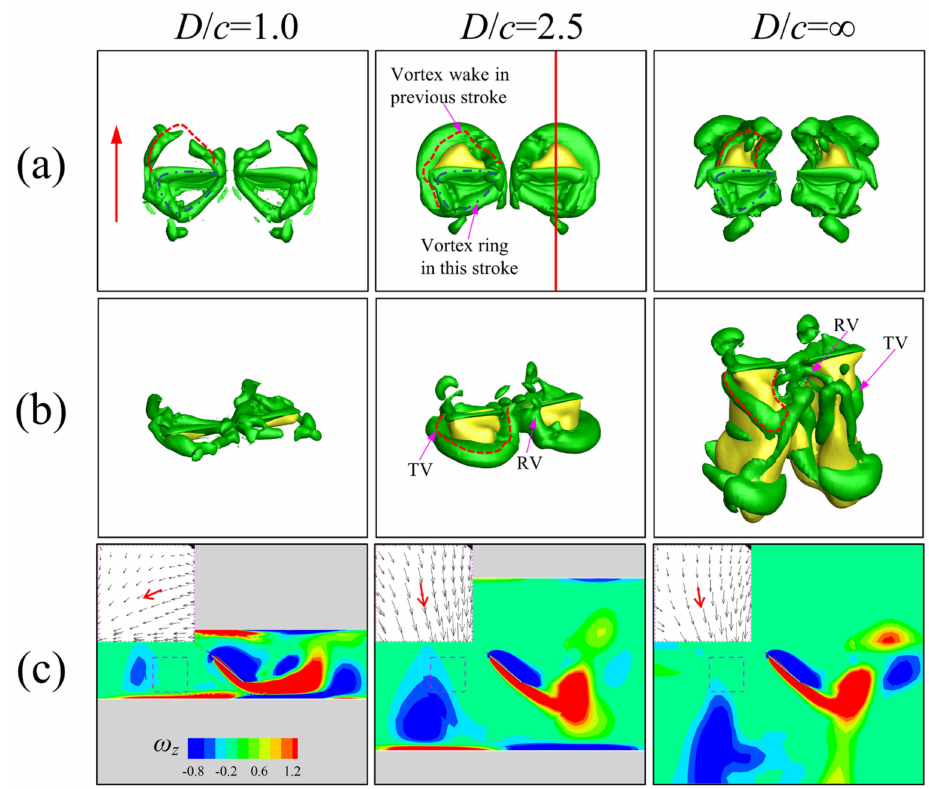
Figure 21. ( a ) Top view; ( b ) oblique view of the iso-Q surface (green) and iso-vertical velocity surface (yellow) showing the strength of downwash; and ( c ) spanwise vorticity distributions on a slice at τ = 0.25 for D / c = 1.0, 2.5 and ∞ at Re = 100. The red arrow and red line in ( a ) give the stroke direction and the slice position,